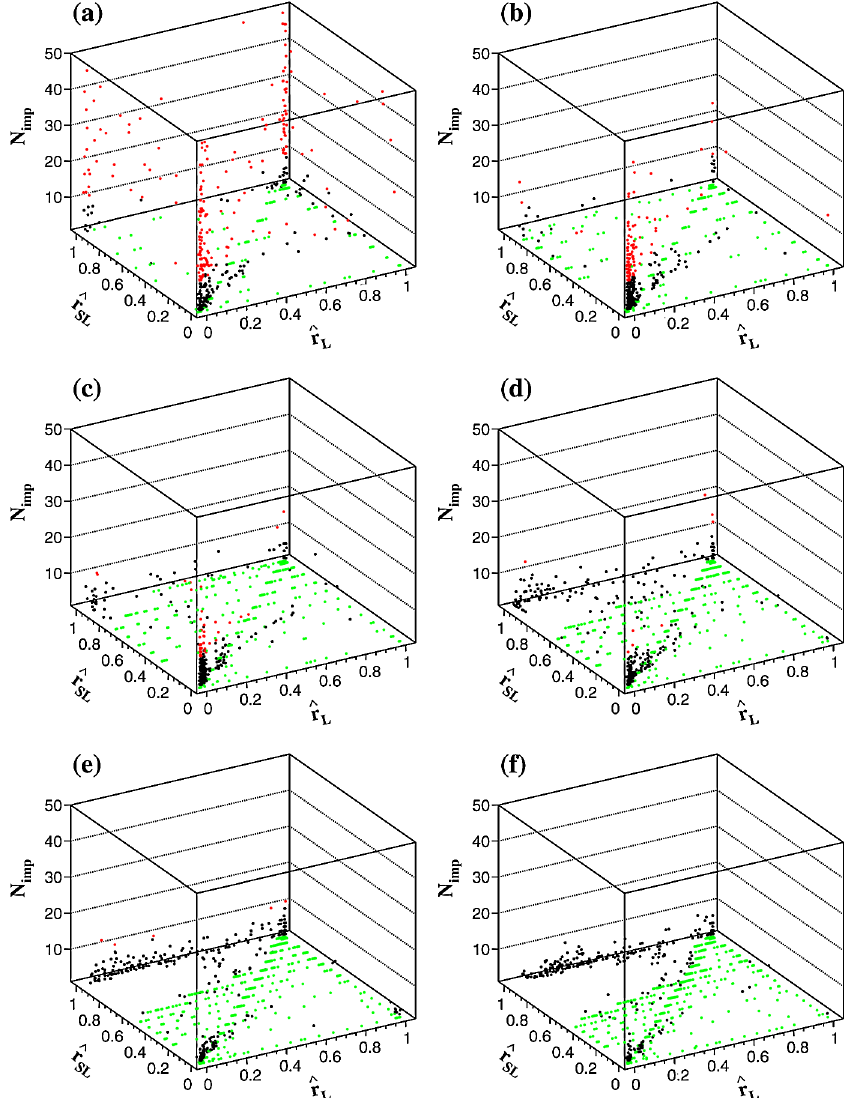
FIG. 8. Number of impacts as functions of the normalized radial positions at the second last and the last impacts of electrons for ¼ 390 kW , and (cid:1) ¼ 0 . depths: (a) 0.6 mm, (b) 0.8 mm, (c) 1.0 mm, (d) 1.2 mm, (e) 1.4 mm, and (f) 1.6 mm for a pitch of 2.0 mm, P in Different points correspond to different initial rf phases and electron positions. The region of ^ r ¼ 0 ( ^ r ¼ 1 ) corresponds to the radial (cid:1) depth = 2 ( r þ depth = 2 ). In the case of N ¼ 1 , shown in green, ^ r indicates the initial position. Electrons with position of r out out imp SL N < 10 ( 10 ^ N ^ 50 ) are shown in black (red). The electrons for N > 50 are not shown in the range of 1 < N imp imp imp imp